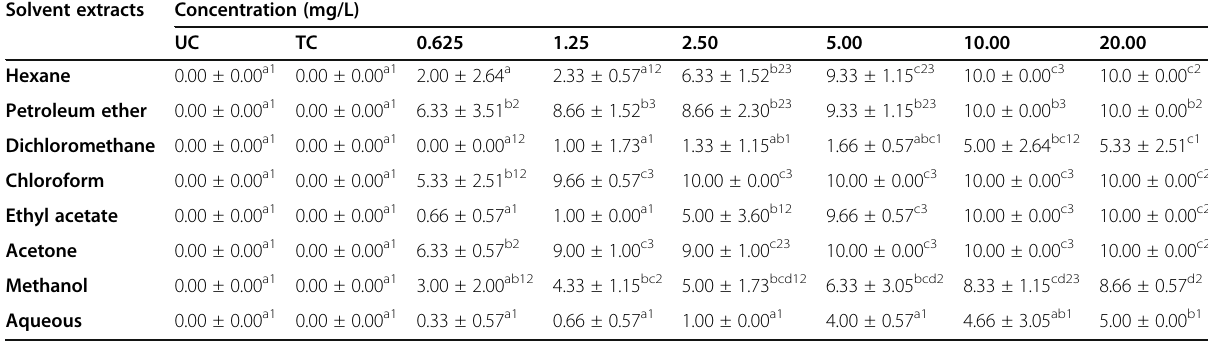
Table 4 Adulticidal activity of Nicotiana tabacum leaf extracts against Sitophilus oryzae at 48 h Solvent